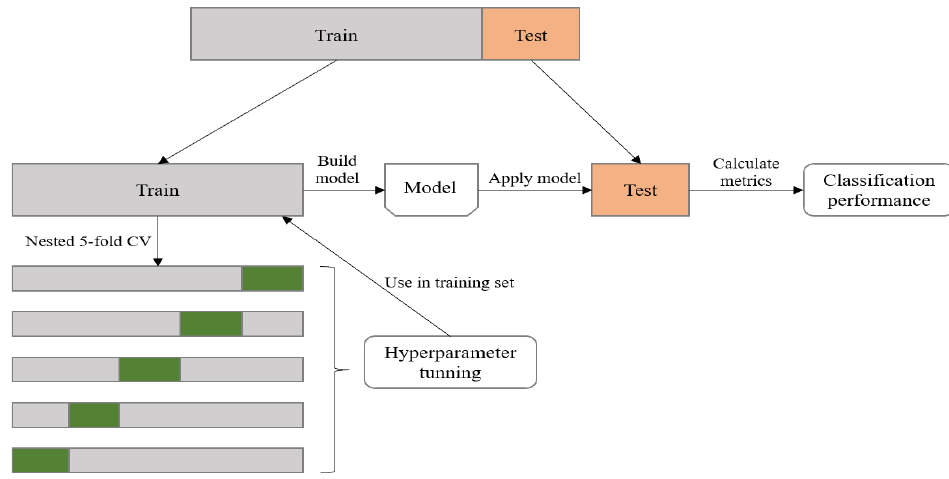
Figure 2. The flowchart of model training, parameter tuning, and performance evaluation.